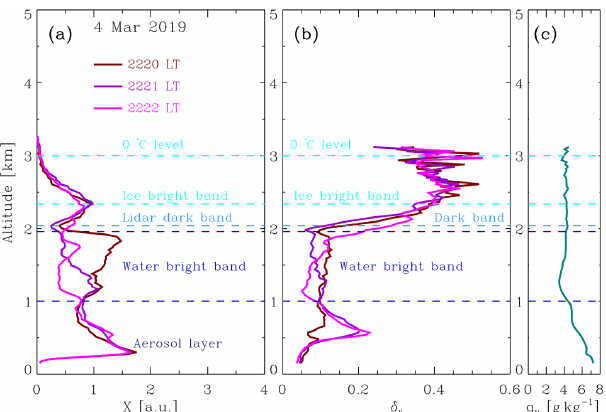
Figure 9. Three 1min lidar X and δ v profiles obtained from 22:20 to 22:22LT on 4 March 2019 and a 1h averaged lidar q v profile centered at 22:21LT on the same day; the profiles exhibit the ver- tical structure of the X and δ v precipitation streaks as well as the water vapor mixing ratio at the onset of the moderate warm-front precipitation